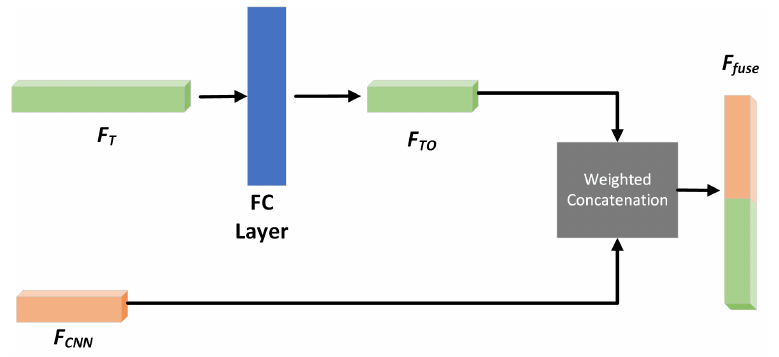
Figure 5. The weighted concatenation method for fusing CNN features F CNN and traditional hand- crafted features F T . First, a fully-connected layer is adopted to ensure that the dimension of F T is unified with that of F CNN . Then, we set two learnable weight parameters α and β to reveal the importance of different features. Finally, the two features are fused by the concatenation